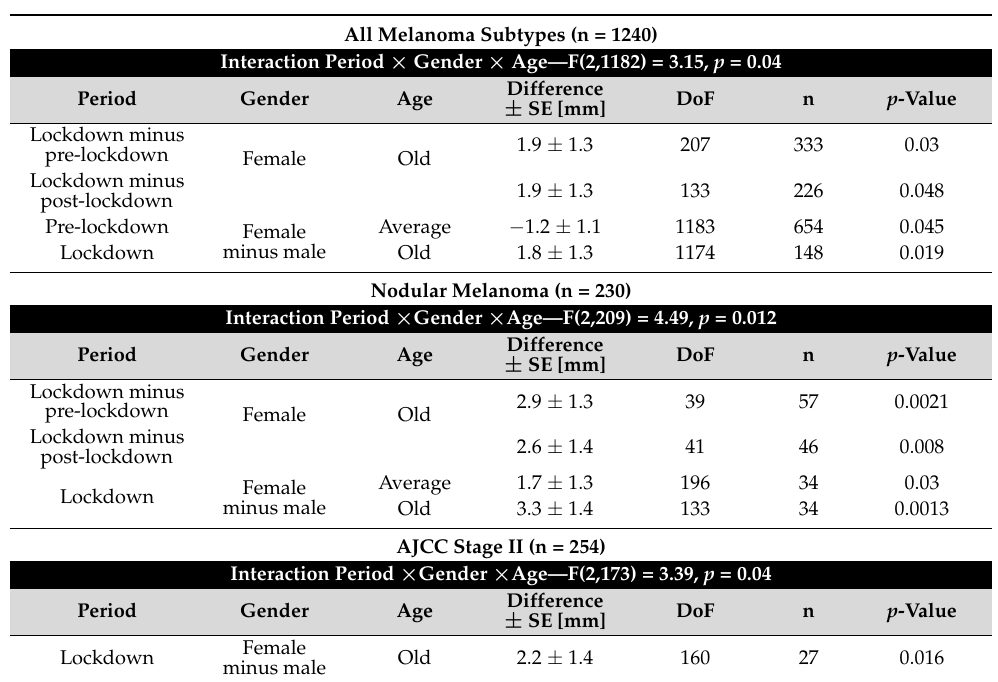
Table 2. Significant pairwise differences for Breslow thickness in post-hoc analysis for significant interactions containing lockdown period as a factor.